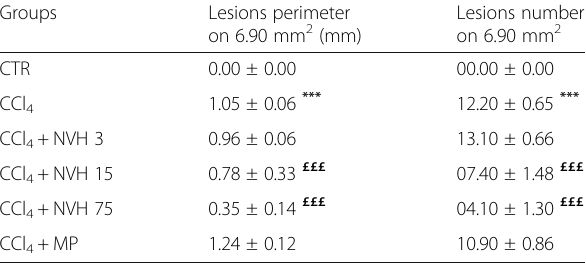
Table 2 Characteristic semi-quantitative evaluation of lesions